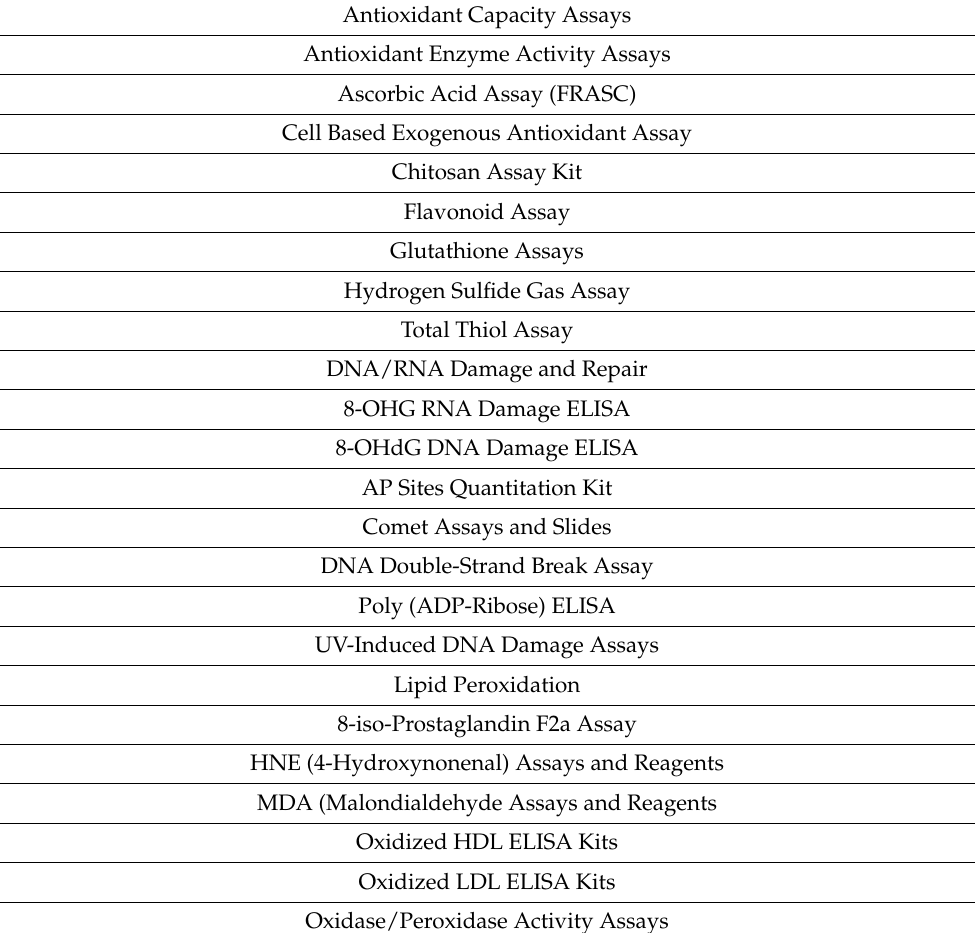
Table 1. The different antioxidant